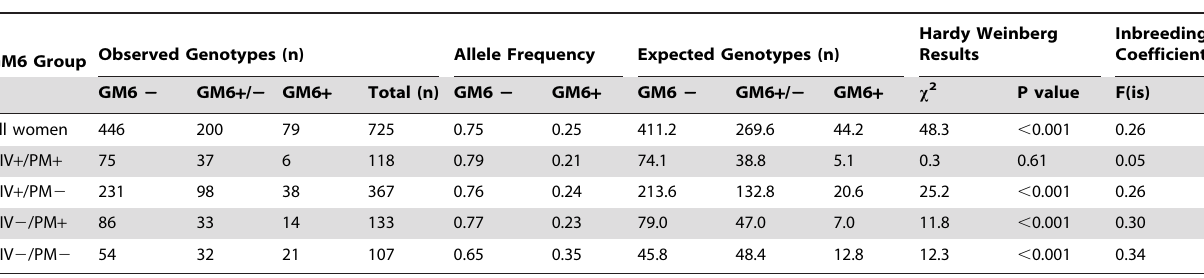
Table 6. Hardy-Weinberg Equilibrium Test for GM6 genotypes.